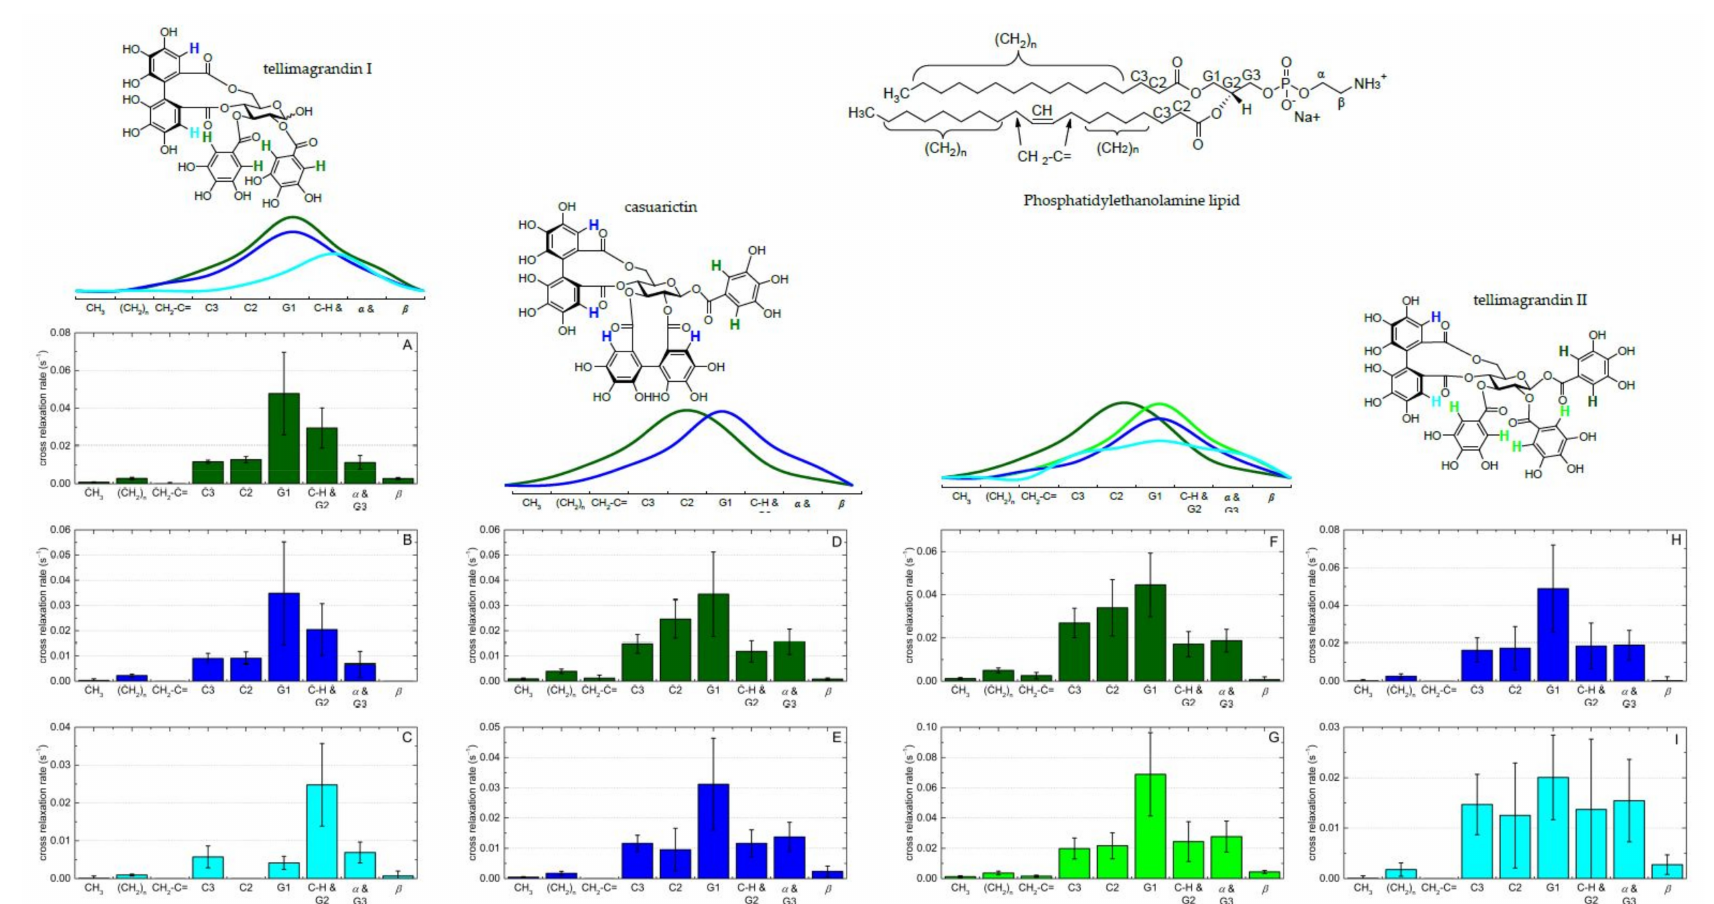
Figure 4. The cross-relaxation rates (s –1 ) between different protons of ellagitannins and lipid protons of Escherichia coli obtained from HR–MAS NMR by nuclear Overhauser effect measurement with a mixing time of 0.1 ms [34]. The cross-relaxation rates provide the distribution functions of the ( A ) galloyl group protons attached to glucose O2 and O3, ( B ) hexahydroxydiphenoyl (HHDP) protons attached to glucose O6, ( C ) HHDP protons attached to glucose O4, ( D ) galloyl group protons attached to glucose O1, ( E ) HHDP protons attached to glucose O2, O3, O4 and O6, ( F ) galloyl group protons attached to glucose O1, ( G ) galloyl group protons attached to glucose O2 and O3, ( H ) HHDP protons attached to glucose O6, and ( I ) HHDP protons attached to glucose O4. Above the cross-relaxation rates, sketches of the approximate membrane location of ellagitannins are